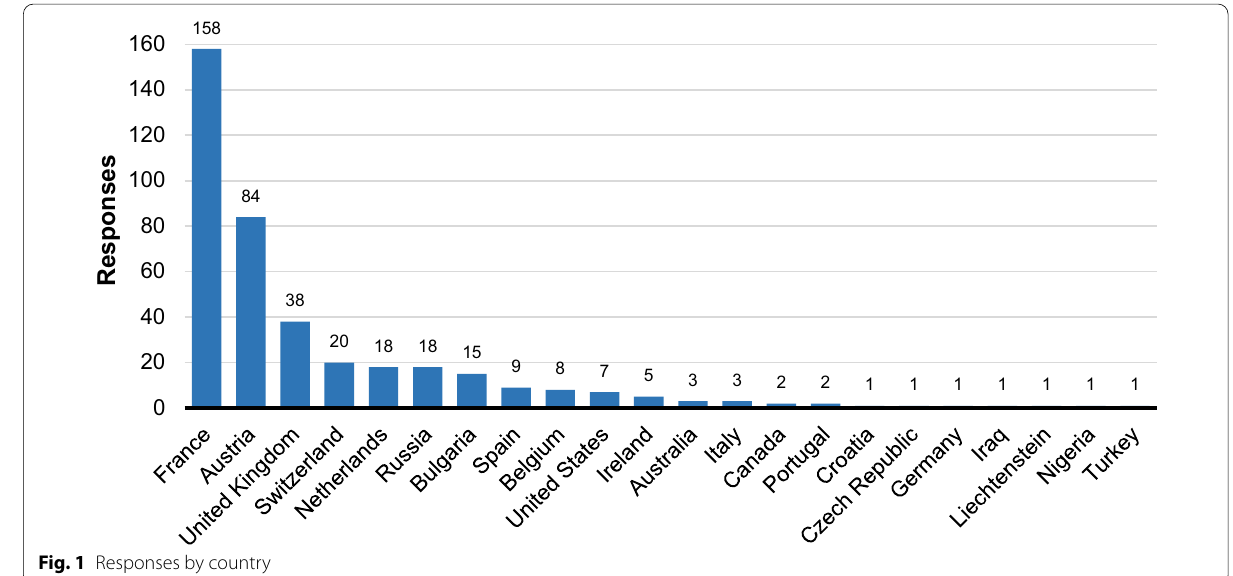
Fig. 1 Responses by country